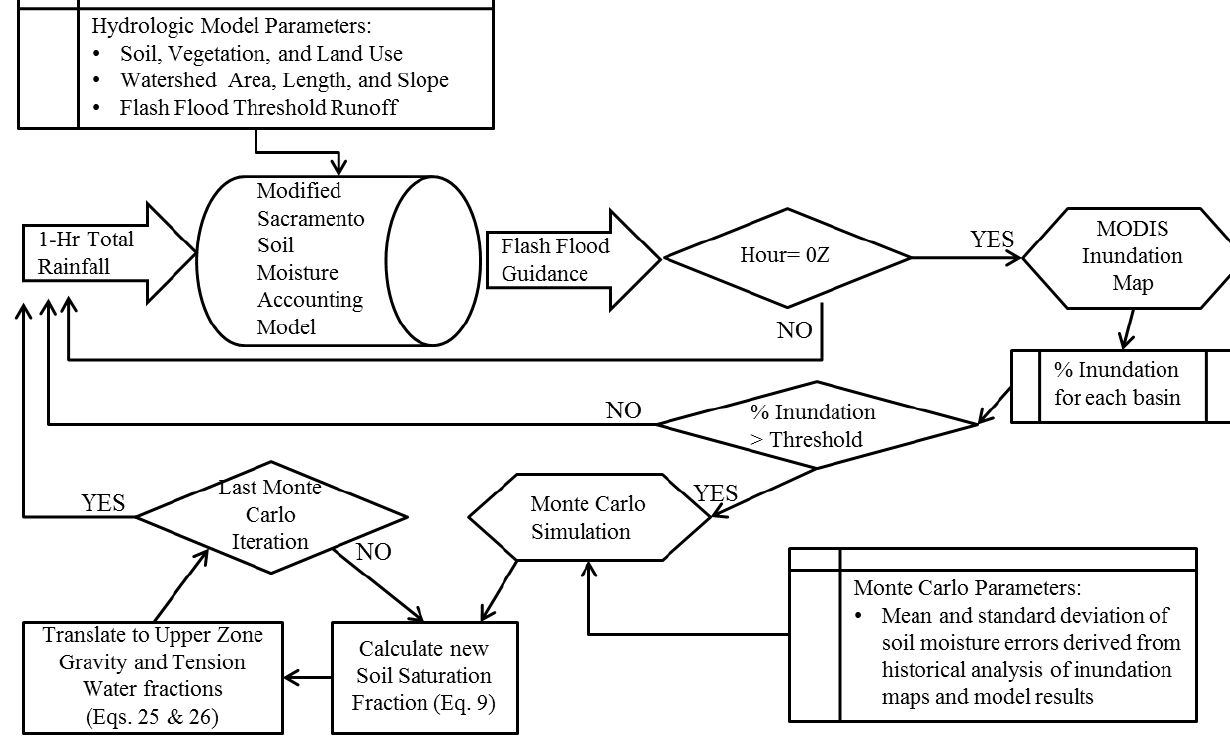
Figure 3. Flow chart of observation assimilation procedure in to modeling